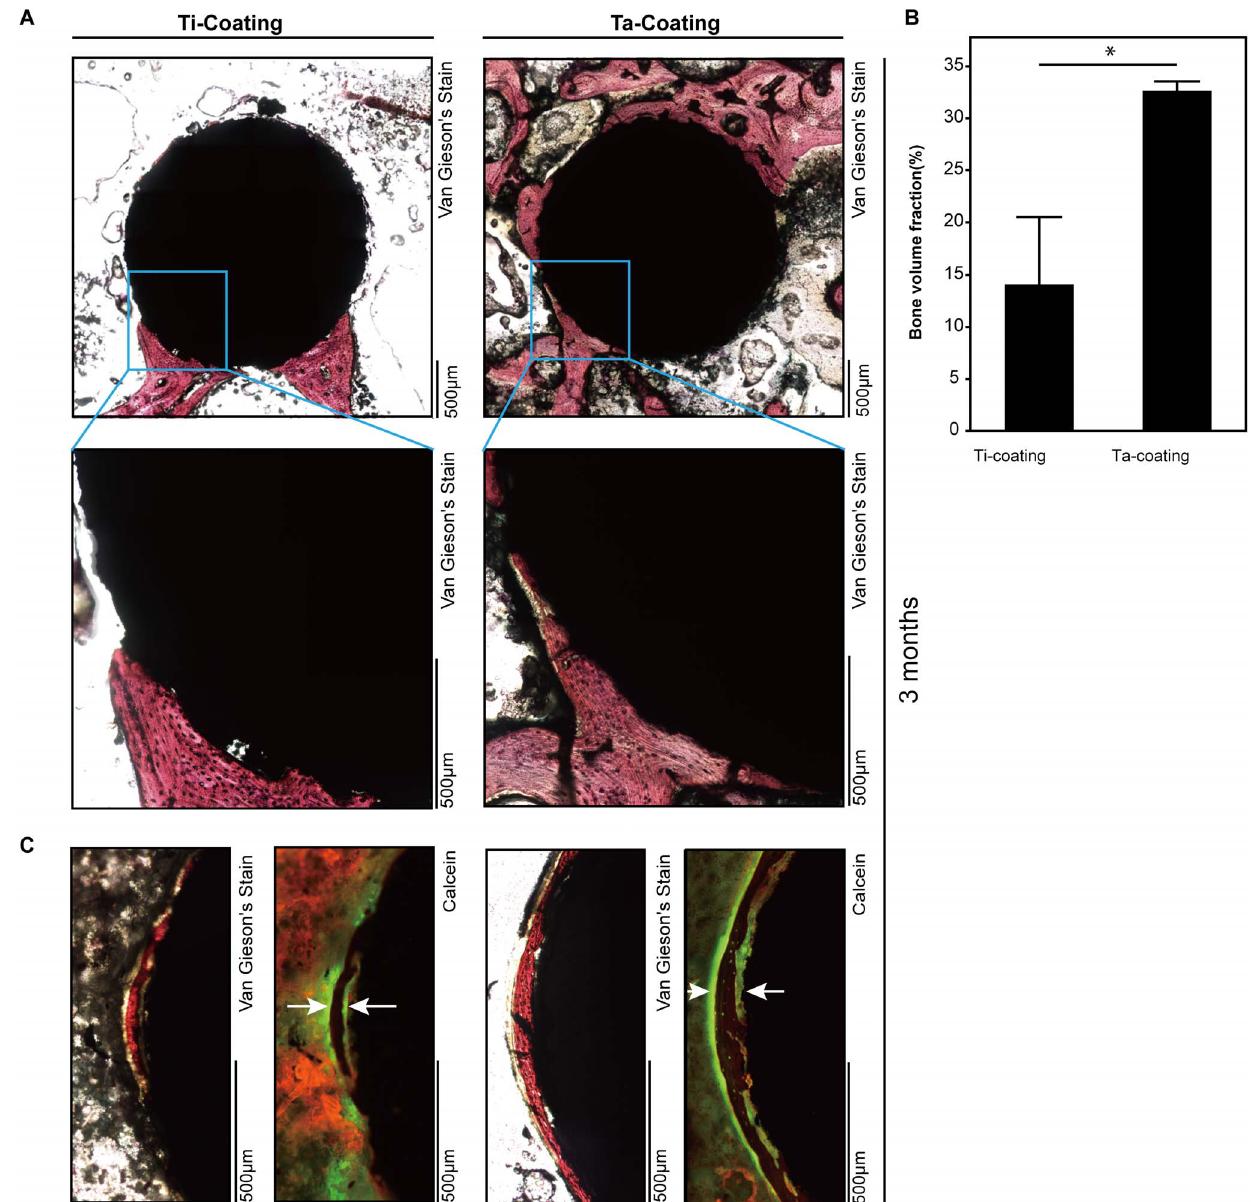
Figure 6. New bone formation around porous Ta and Ti coating implants in vivo. ( A ) Van Gieson’s Picric–Fuchsin stain of new bone formation around implants. Red indicates the bone around implants in 3 months. ( B ) Quantification of new bone formation around the coating implants in 3 months in vivo (t-test, assuming unequal variances, error bars represent 6 SD, n =3; Ti coating, 14.0741 6 6.46293; Ta coating, 32.6501 6 0.90721; Prob . |t|, 0.0358*). ( C ) Double fluorescence labeling was used to represent the mineral apposition rate of new bone formation. Green with white arrow indicates the calcein fluorescence labels in 3 months.